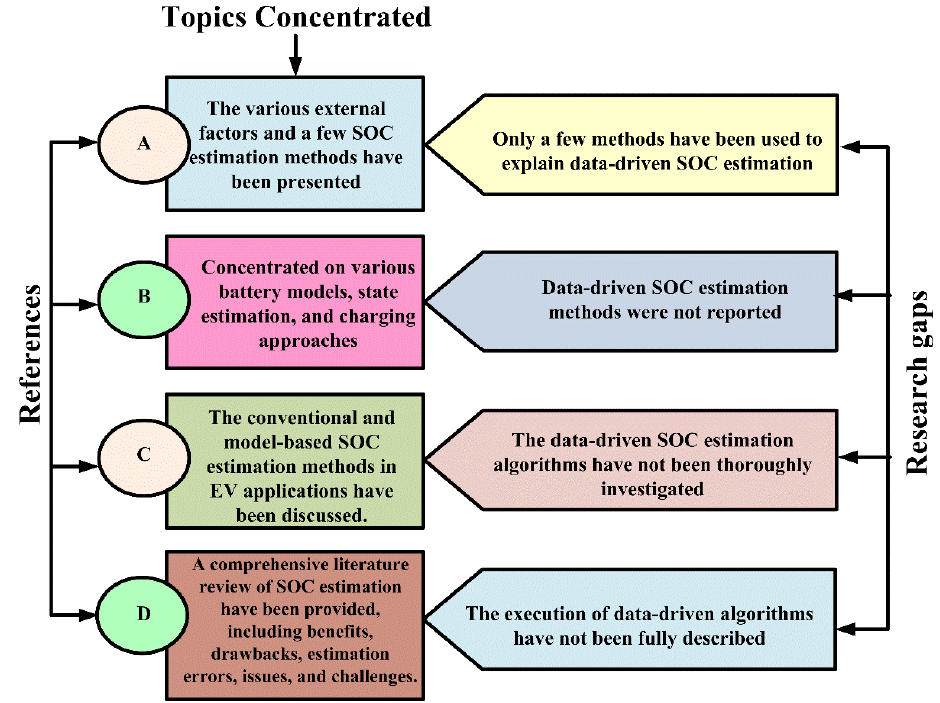
Figure 5. Overview of a few literature studies on different SOC estimation methods. “A” is referred to as [23], “B” is referred to as [34], “C” is referred to as [37] and “D” is referred to as [49].